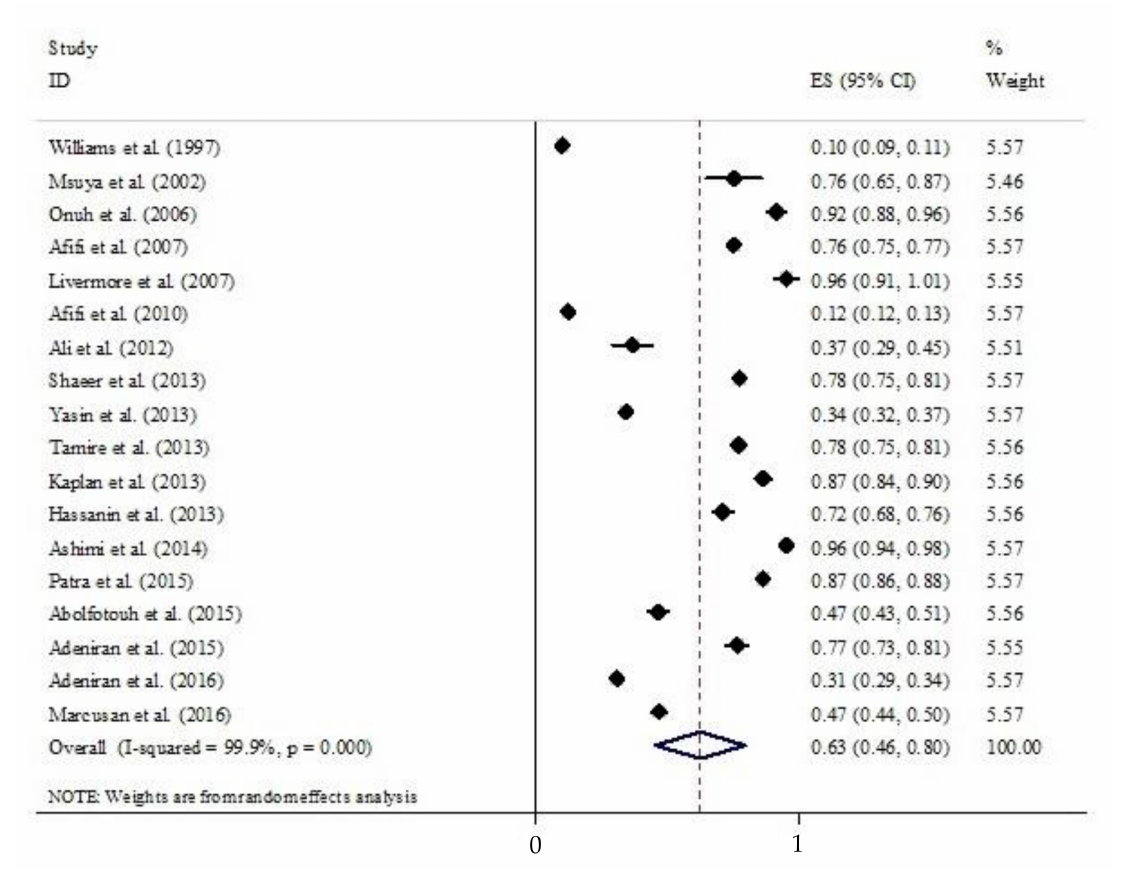
Figure 5. Attitudes toward circumcising daughters now or in the